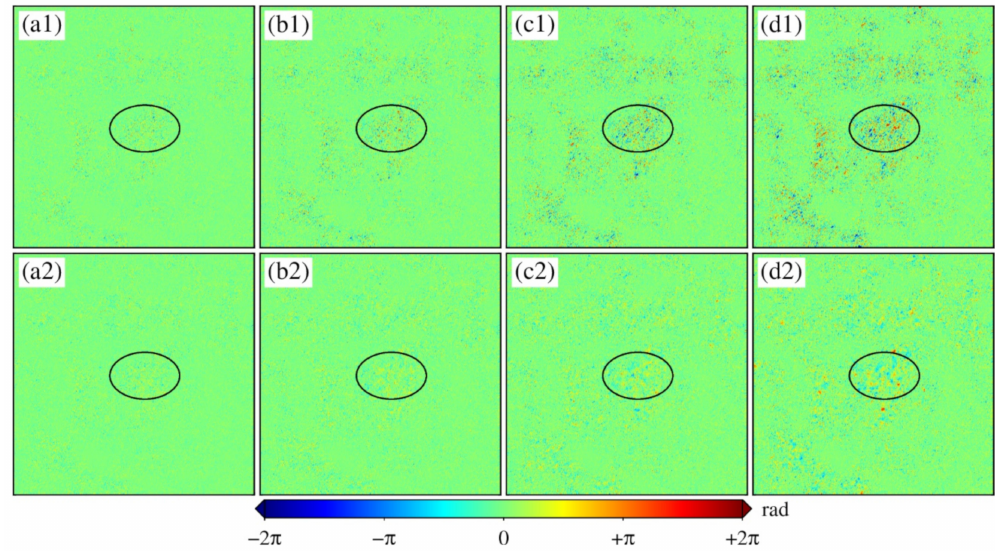
Figure 16. Comparison of unwrapped errors under different noise levels. ( a1 – d1 ) The unwrapping errors of mcf method at four noise levels; ( a2 – d2 ) the unwrapping error of HNCA method at four noise levels. Table 3 lists the RMSE and its accuracy improvement under four different noise levels.